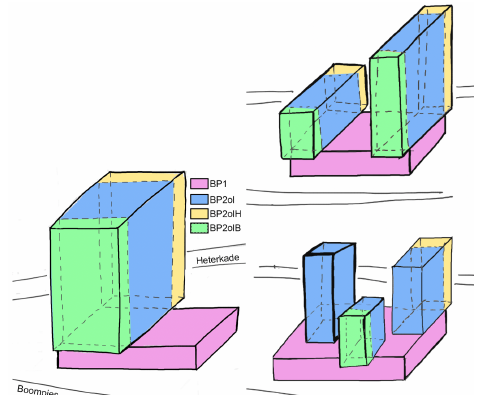
Figure 3. Building segmentation to check overlap percentage and overhangs dimensions, where BP 2 ol is the part of BP 2 with a footprint overlapping the BP 1 one; BP 2 ohB and BP 2 ohH are the BP 2 parts with outline overhanging, towards “Boompjes” and “Heterkade” streets respectively. BP 2 = BP 2 ol ∪ BP 2 ohB ∪ BP 2